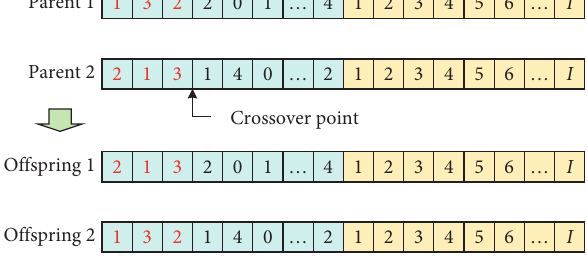
Figure 4: An example of a single point crossover operation.